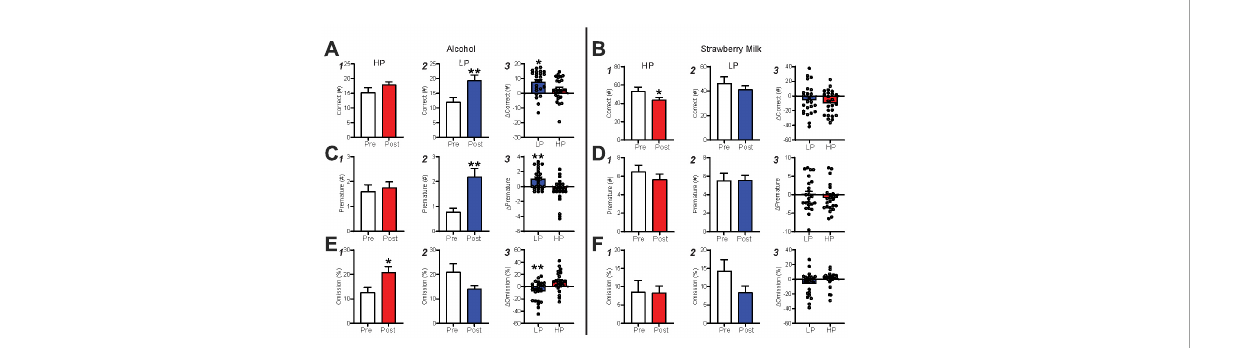
FIGURE4 Intermittent alcohol exposure promotes responding in the 5-CSRTT. (A) LP mice gave more correct responses after IA2BC and had an overall greater change in correct than HP mice. (B) HP mice displayed a decrease in correct and had a similar change in performance as LP mice during SM sessions. (C) LP premature responding greatly increased post-IA2BC and had a greater performance change than HP mice, this was not seen during (D) SM sessions. (E) % Omissions were greater in HP post-IA2BC and LP mice had a greater performance change than HP mice. (F) No differences in % omission was found during SM sessions. n = 24/group, * p < 0.05, ** p < 0.01 for effect of group. All data are expressed as ± standard error